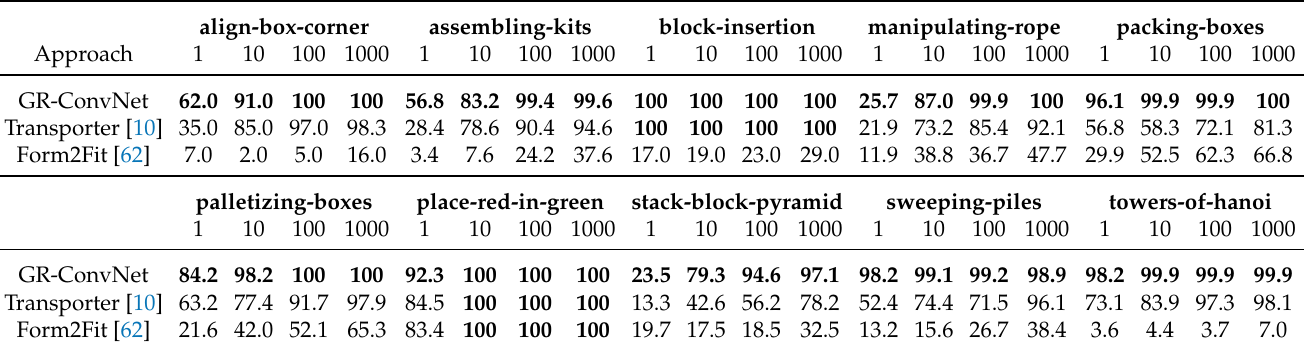
Table 9. GR-ConvNet performance on Ravens-10 benchmark tasks. Task success rate (mean %) vs. demonstration used in